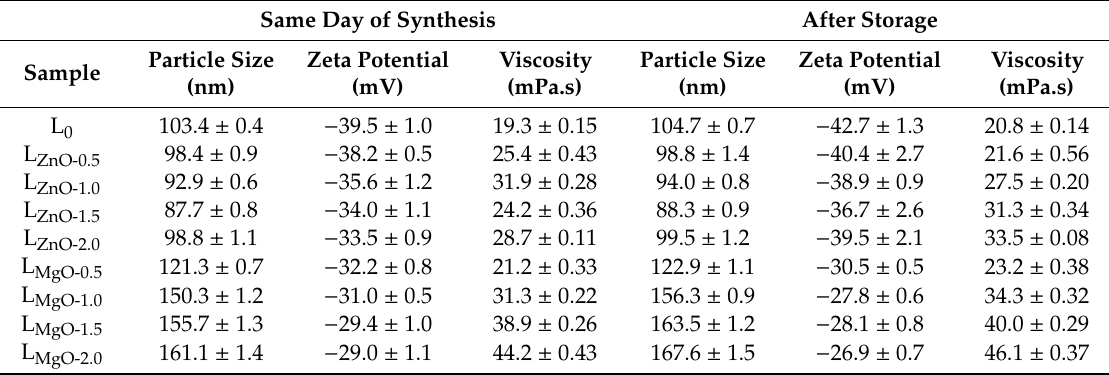
Table 6. Results of storage stability testing (in terms of particle size, zeta potential, and viscosity) of self-crosslinking latex binders differing in type and content of inorganic nanoparticles before and after storing at 50 °C for 60 days. Same Day of Synthesis After Storage